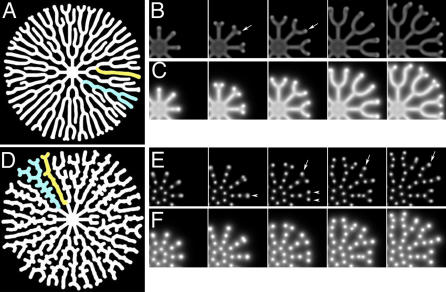
Distinctive Dendritic Patterns Obtained from the Computer Simulation of the Cell Compartment Model(A–C) and (D–F) Two distinct patterns obtained by using different parameter values in the activator–suppressor model. Whole images of dendritic trees (A,D), magnified images of the activator (B,E) and those of the suppressor (C,F). Examples of branch-poor arbors and branch-rich arbors were indicated in yellow and blue, respectively, (A) and (D). Density of the activator is relatively high at the terminal of each branch (arrows in “B”). Alternatively, dendrites elongate as new spots are generated (arrows in “E”) and bifurcate as spots undergo fission (arrowheads in “E”). Parameter values were pa = 0.9 and pe = 6.5 (A–C) and pa = 0.5 and pe = 2.6 (D–F). Other parameters were pb = 0.8, d = 30.0, ph = 1.0, Tr = 1.0, Amax = 30.0, R = 0.004, and γ = 625. The grid size is 800 × 800, dx = 0.02, and dt = 1 × 10−6.